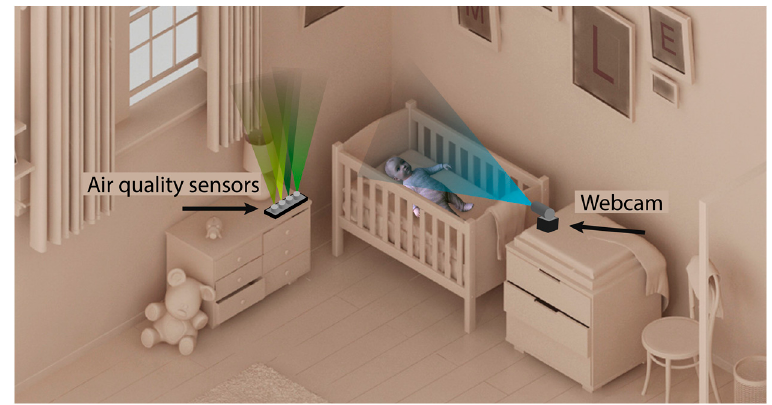
Figure 7. Location of the nodes in the newborn’s room.